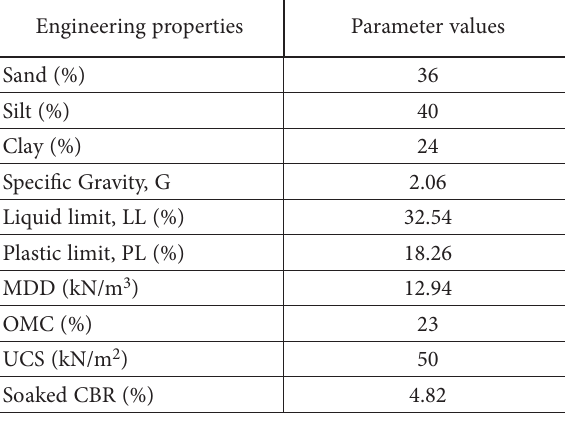
Table 1. Engineering properties of the soil sample collected from the landfill site